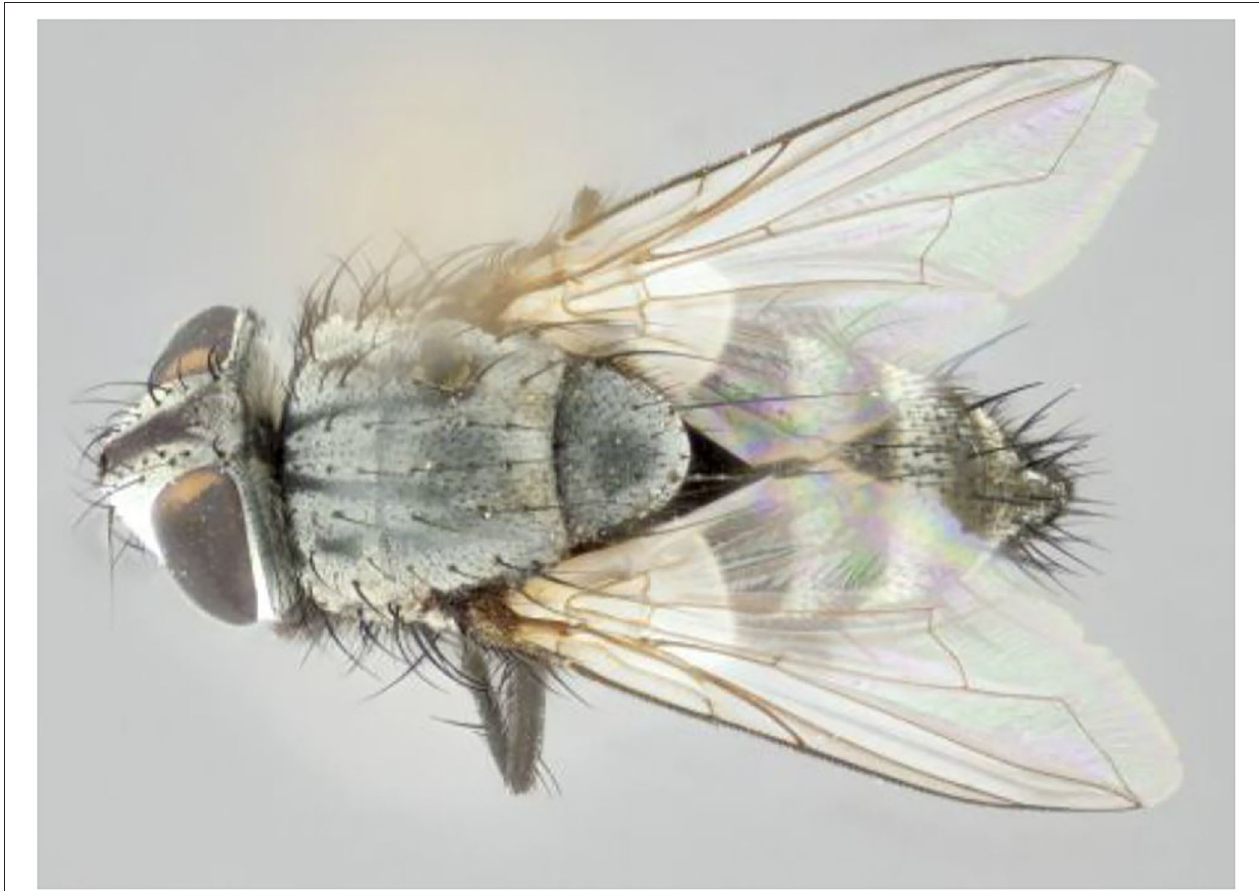
FIGURE 2 | Myiopharus doryphoae (Diptera: Tachinidae) parasitoid of Leptinotarsa decemlineata